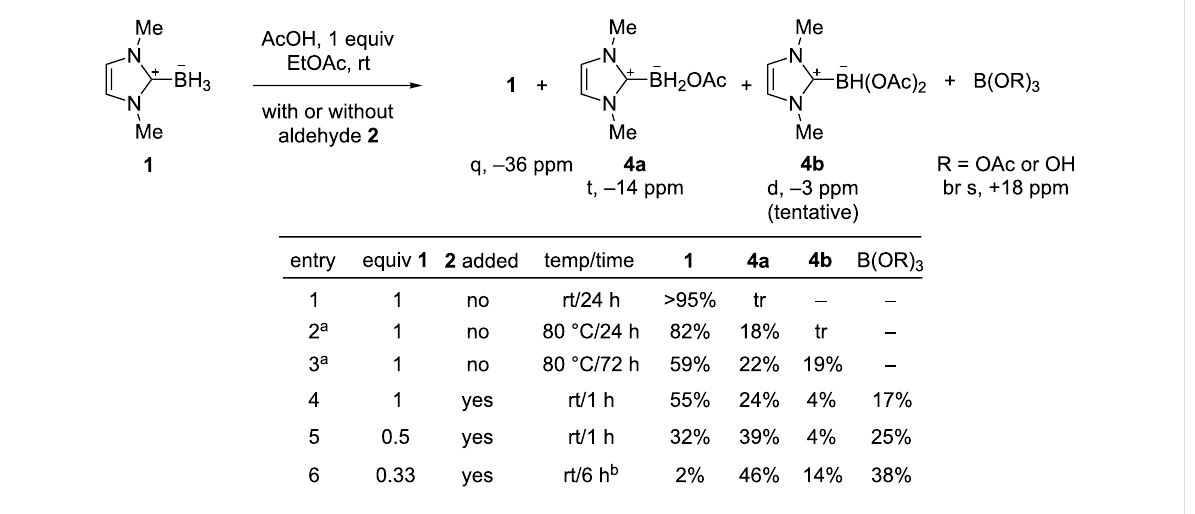
and 17% of a broad resonance at about +18 ppm. This is not in the region expected for an NHC-borane, but is instead where boric acid and similar molecules resonance. Thus, it might be B(OAc) 3 , but it could also be boric acid itself (the solvent was not dried) or some intermediate product. We write this simply as B(OR) 3 . With 0.5 equiv 1 (entry 5), there was 32% of the starting 1 , 39% 4a , 4% 4b and 25% B(OR) 3 . The final reaction with 0.33 equiv of 1 was considerably slower (entry 6). Alde- hyde 2 still remained after 6 h, and the 11 B NMR spectrum shows 2% starting 1 , 46% 4a , 14% 4b and 38% B(OR) 3 . These